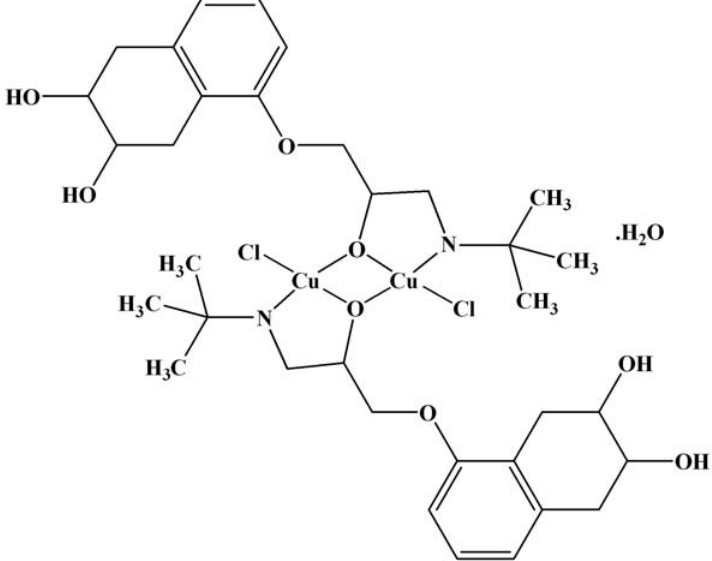
Fig. 9 Proposed structure of the dinuclear Cu(II) complex,